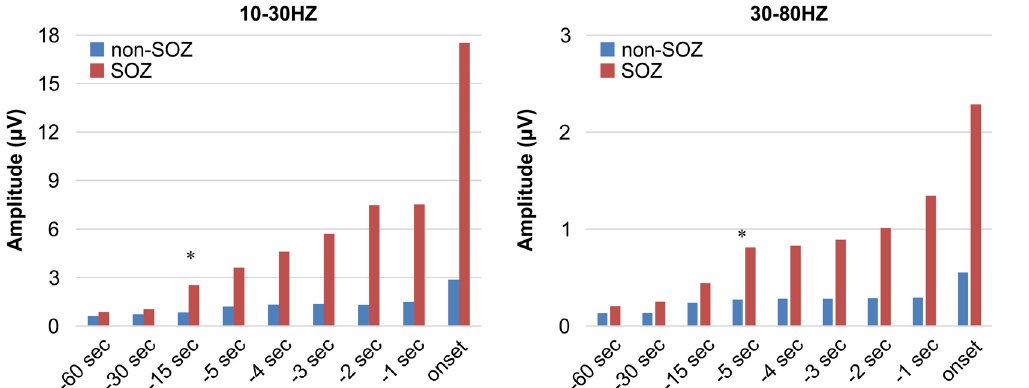
Fig 4. Statistical analysis of the frequency components in the SOZ and non-SOZ electrodes. A statistically significant difference in power spectrogram was detected at 10 – 30 Hz from 15 s before seizure onset and at 30 – 80 Hz from 5 s before seizure onset, respectively. * represents statistical significance (p <